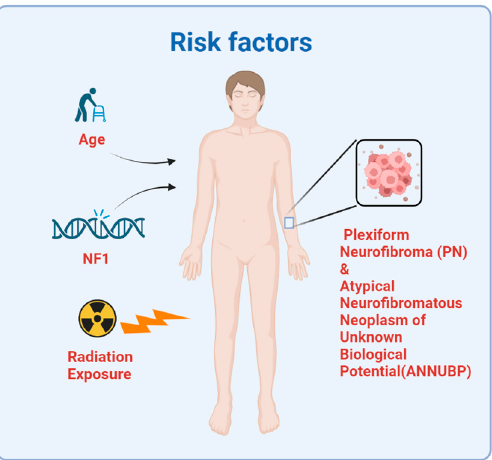
Figure 2. Risk factors of MPNST. MPNST often occurs in patients aged 30–50. About 50% of MPNST cases are associated with NF1, and about 10% of MPNST patients have a history of radiation exposure. The possession of PN and ANNUBP has malignant potential for MPNST development.